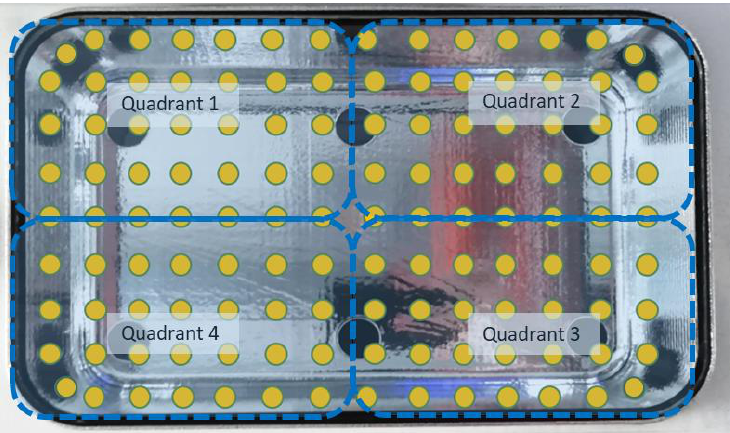
Figure 2. The 126 points selected on the quartz surface for photonic measurement are represented in yellow, while the dashed blue lines represent the different quadrants of the base.